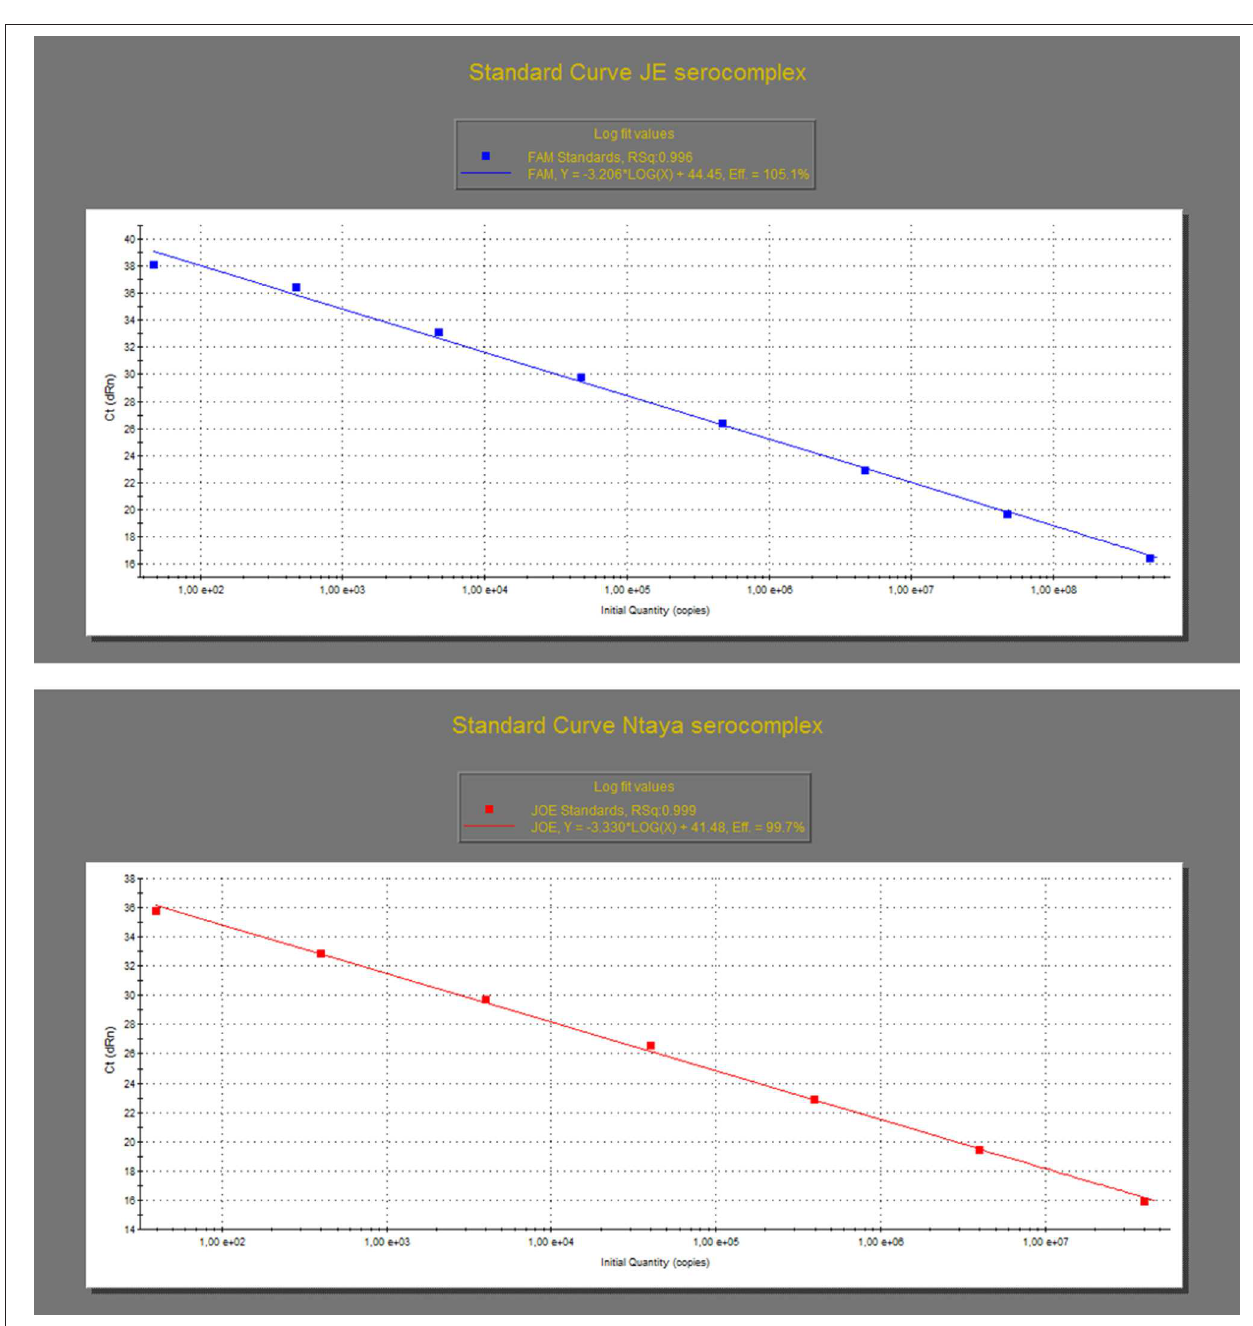
FIGURE 1 | Standard curves of the dRRT-PCR for the detection of JE (top graph) and Ntaya flavivirus serocomplexes (bottom graph). The curves were generated by analysis of triplicates of 10-fold serial dilutions of the quantified in vitro -transcribed WNV (top graph) and BAGV (bottom graph) RNA standards produced as synthetic positive controls. Each (cid:5) corresponds to the mean value of three